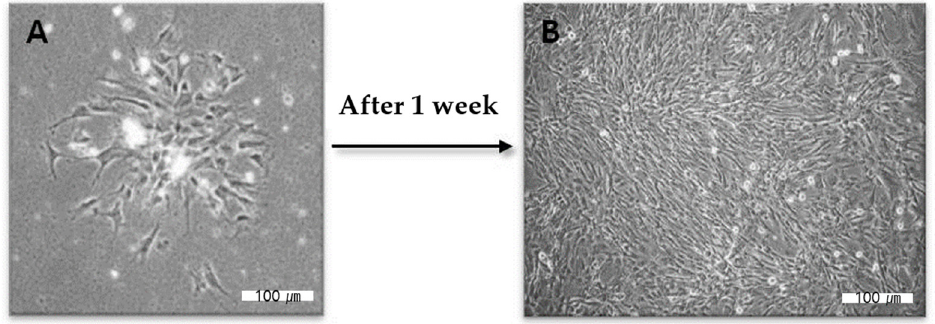
Figure 14. ( A , B ) Proliferation of human dental pulp cells over a week. Figures were taken from an optical microscope.